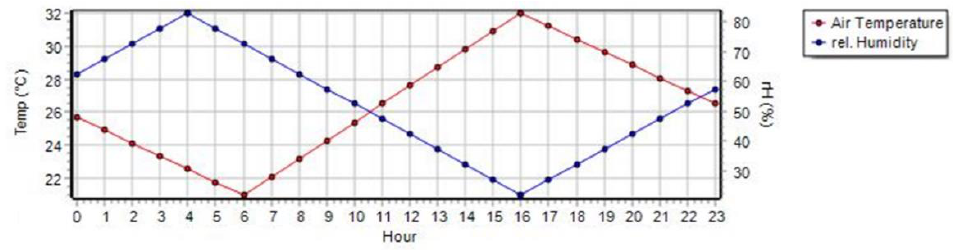
Figure 4. Variation in the air temperature and the relative humidity during the day, extracted from the meteorological input data interface of the ENVI-Met software.